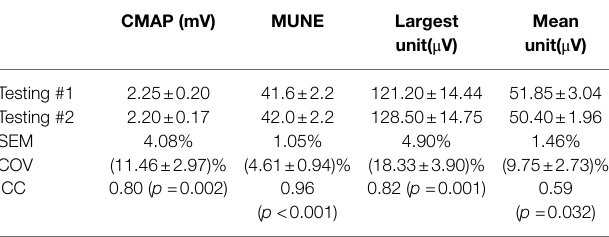
CMAP, compound muscle action potential; MUNE, motor unit number estimation; ICC, intraclass correlation coefficient; SEM, standard error of measurement; and COV, coefficient of